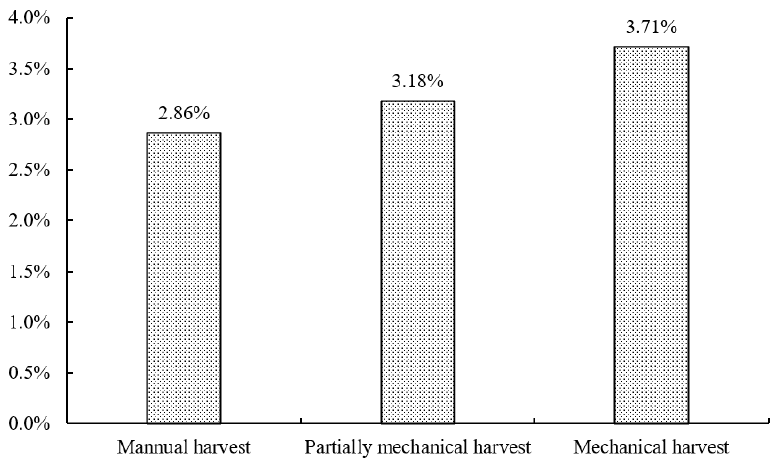
Figure 3. Rice harvest losses for different harvest methods.